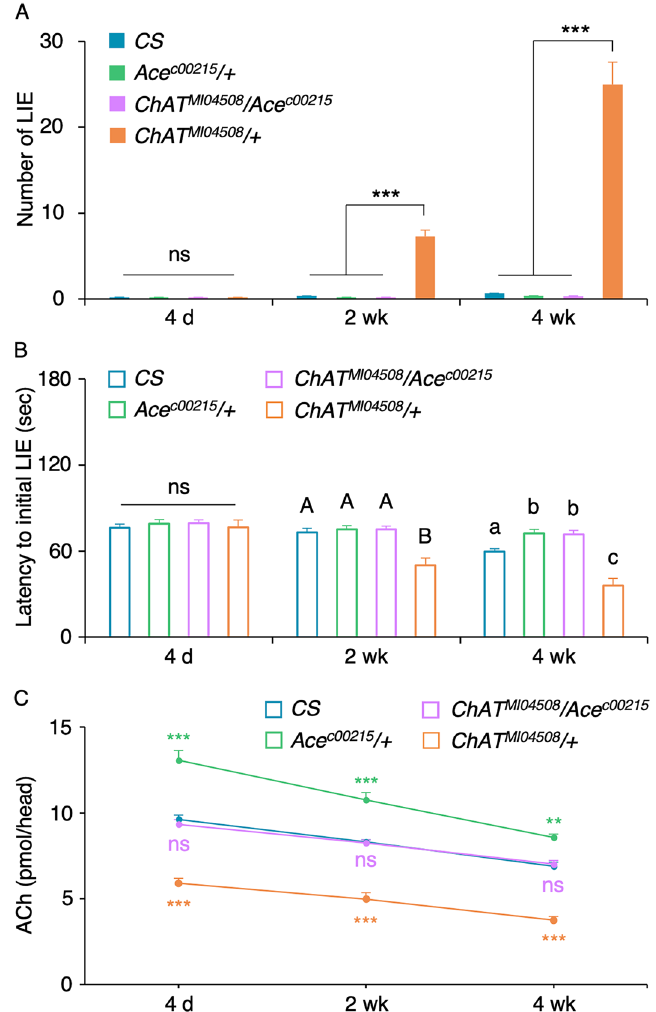
Figure 3. The heterozygous Ace mutation fully suppresses the ChAT/ + ’s inhibitory control deficits. (A ) The double heterozygous ChAT MI04508 /Ace c00215 (light purple) mutants displayed robust movement restraint with rarely detectable LIEs similar to CS (blue), Ace c00215 / + (light green) and ChAT MI04508 / + (orange) at the age of 4 day (one way ANOVA with post hoc Tukey: ns, p > 0.05; n = 12). At the ages of 2 week and 4 week, the ChAT MI04508 / Ace c00215 mutants displayed a small increase in LIE similar to CS and Ace c00215 / + but the level was significantly different from that of ChAT MI04508 / + (ANOVA with post hoc Tukey: ***, p < 0.0001; n = 12). ( B ) The latency to the initial LIE was comparable in all genotypes under study at the age of 4 day (ANOVA with post hoc Tukey: ns, p > 0.05; n = 12). The double heterozygous ChAT MI04508 /Ace c00215 exhibited the significantly delayed latency compared to that of ChAT MI04508 / + at the ages of 2 week and 4 week (ANOVA with post hoc Tukey: different letters denote statistically significant difference, p < 0.01, n = 12). ( C ) The acetylcholine levels in the double heterozygous ChAT MI04508 /Ace c00215 were comparable to CS , but significantly lower than Ace c00215 / + and significantly higher than ChAT MI04508 / + at all ages. ANOVA with post hoc Tukey multiple comparison of the genotypes within an age: ns, p > 0.05; **, p < 0.005; ***, p < 0.0001; n =